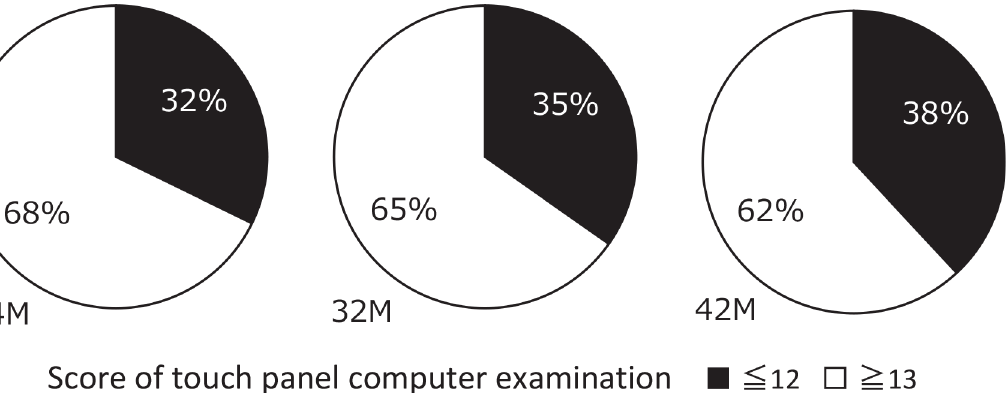
Fig 2. Changes in the ratio of people with normal cognitive function and those with declined cognitive function. White and black portions indicate the ratio of people with normal cognitive function (touch panel computer exam score of (cid:1) 13) and declined cognitive function (exam score of (cid:3) 12), respectively, at 24, 32, and 42 months after the disaster.